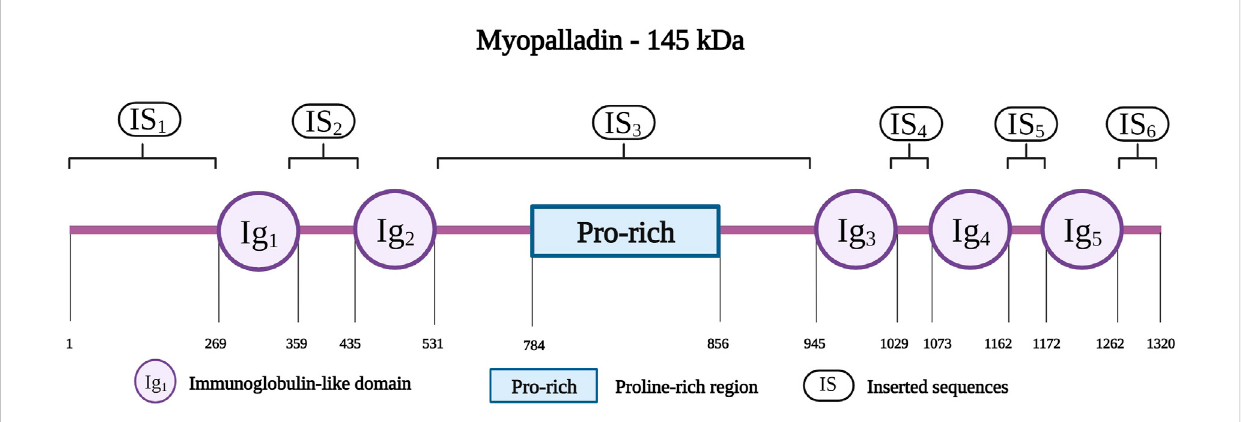
FIGURE 7 Schematic representation of the myopalladin with different residues spanning the fi ve Ig domains (IG1 to IG5), Proline-rich region and the six inserted sequences (IS1 to IS6). Created with